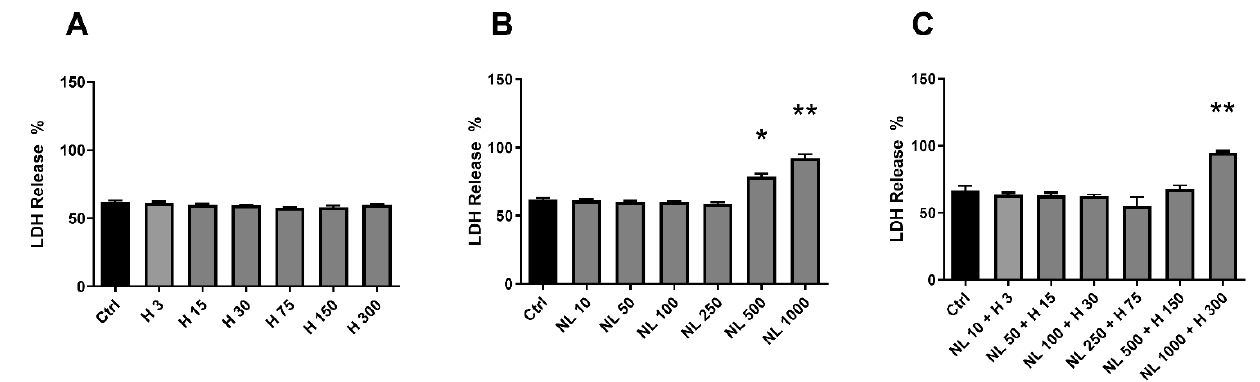
Figure 3. Evaluation of cytotoxicity with increasing concentrations of hop extract, empty nanolipo- somes, and nanoliposomes encapsulating hop extract in chondrocytes. Human chondrocytes were exposed in vitro to increasing concentrations of ( A ) hop extract alone (3 to 300 µ g/mL), ( B ) empty nanoliposomes (10 to 1000 µ g/mL rapeseed lecithin), or ( C ) nanoliposomes encapsulating hop extract (at 10 to 1000 µ g/mL rapeseed lecithin and 3 to 300 µ g/mL hop extract). The potential cytotoxicity of each culture condition was measured by LDH assay on day 7. Ctrl—control cells, meaning chon- drocytes not treated with hop extract alone, empty nanoliposomes, or nanoliposomes encapsulating hop extract; LDH—lactate dehydrogenase; H—hop extract alone; H 3—hop extract alone diluted to a final concentration of 3 µ g/mL; NL—empty nanoliposomes; NL 10—empty nanoliposomes diluted to a final lecithin concentration of 10 µ g/mL; NL + H—hop-extract-loaded nanoliposomes; NL 10 + H 3—nanoliposomes encapsulating hop extract diluted to a final lecithin concentration of 10 µ g/mL and a final hop concentration of 3 µ g/mL; SD—standard deviation. The reported data are represented as mean ± SD of at least four individual experiments. Significance compared to Ctrl is indicated as * for p < 0.01 and ** for p <